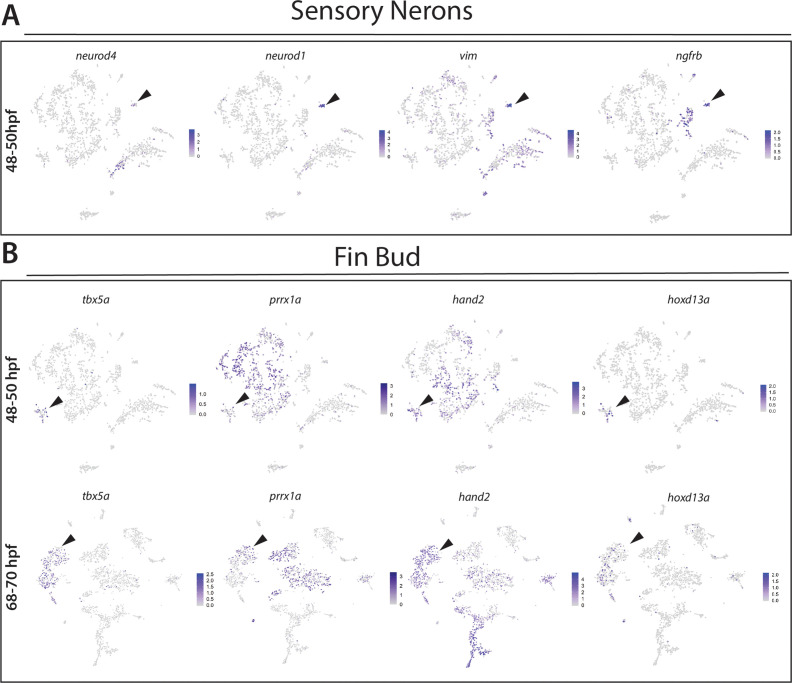
Identification of fin bud and sensory neuronal progenitor cellular populations.(A) Panel of tSNE feature plots of sensory neuronal progenitor markers at 48–50 hpf that show combinatorial expression of neurod4, neurod1, vim, and ngfrb, Cluster of interest denoted by black arrows. (B) Panel of tSNE feature plots of fin bud makers at 48–50 hpf (top) and 68–70 hpf (bottom) that show combinatorial expression of tbx5a, hand2, hoxd13a, and prrx1a. Cluster of interest denoted by black arrows.